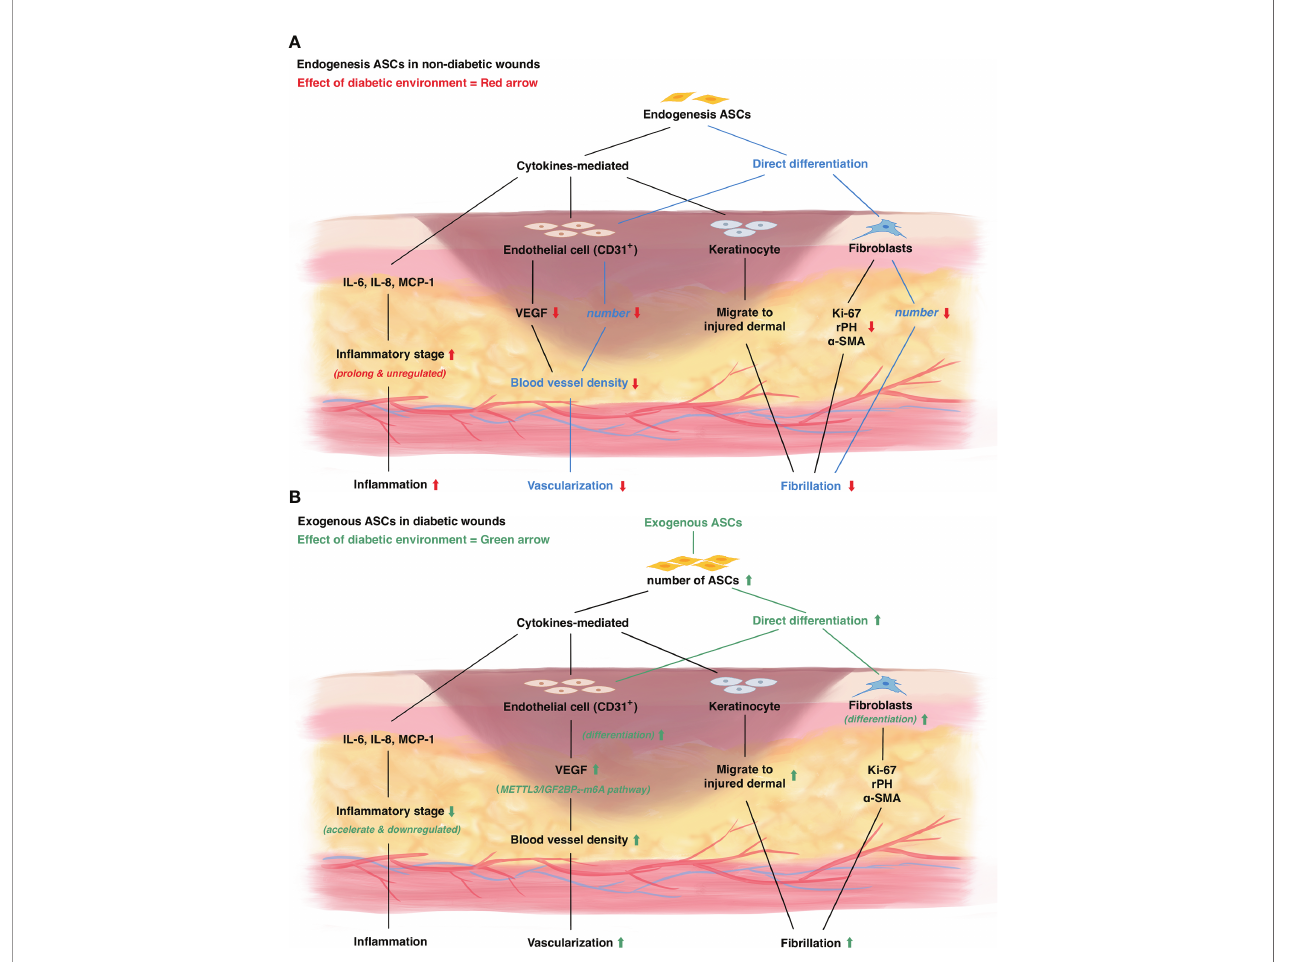
FIGURE 1 | The mechanism of diabetic wound healing and the role of adipose derived stem cells in diabetic wounds. (A) The change of endogenous ASCs in diabetic wounds. Red arrow represents diabetic environment in fl uence on wound healing. (B) The in fl uence of exogenous ASCs on diabetic wounds. Green arrow represents the mechanism of exogenous ASCs treatment on diabetic wound